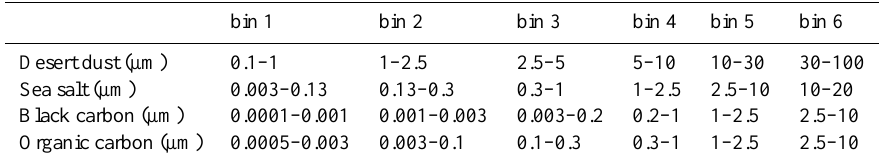
Table 1. Bin ranges of individual primary aerosol species present in